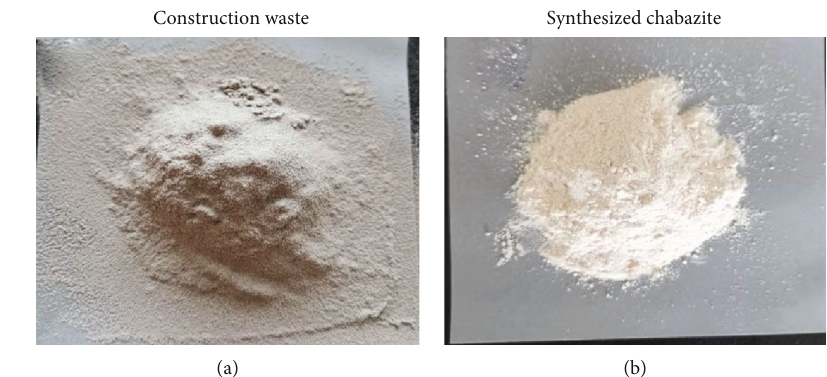
Figure 1: Pictures of (a) construction waste and (b) synthesized chabazite.